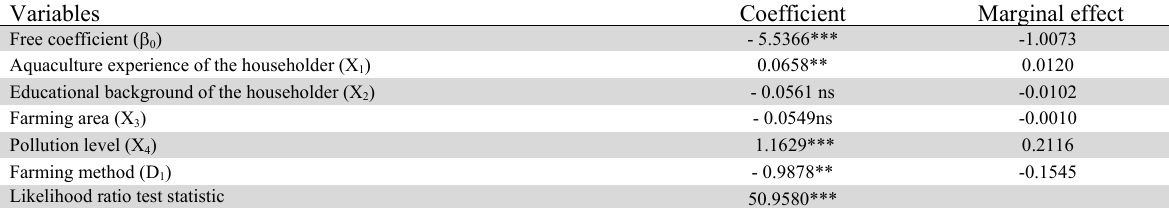
Estimated results of the Logit function Variables Coefficient Marginal